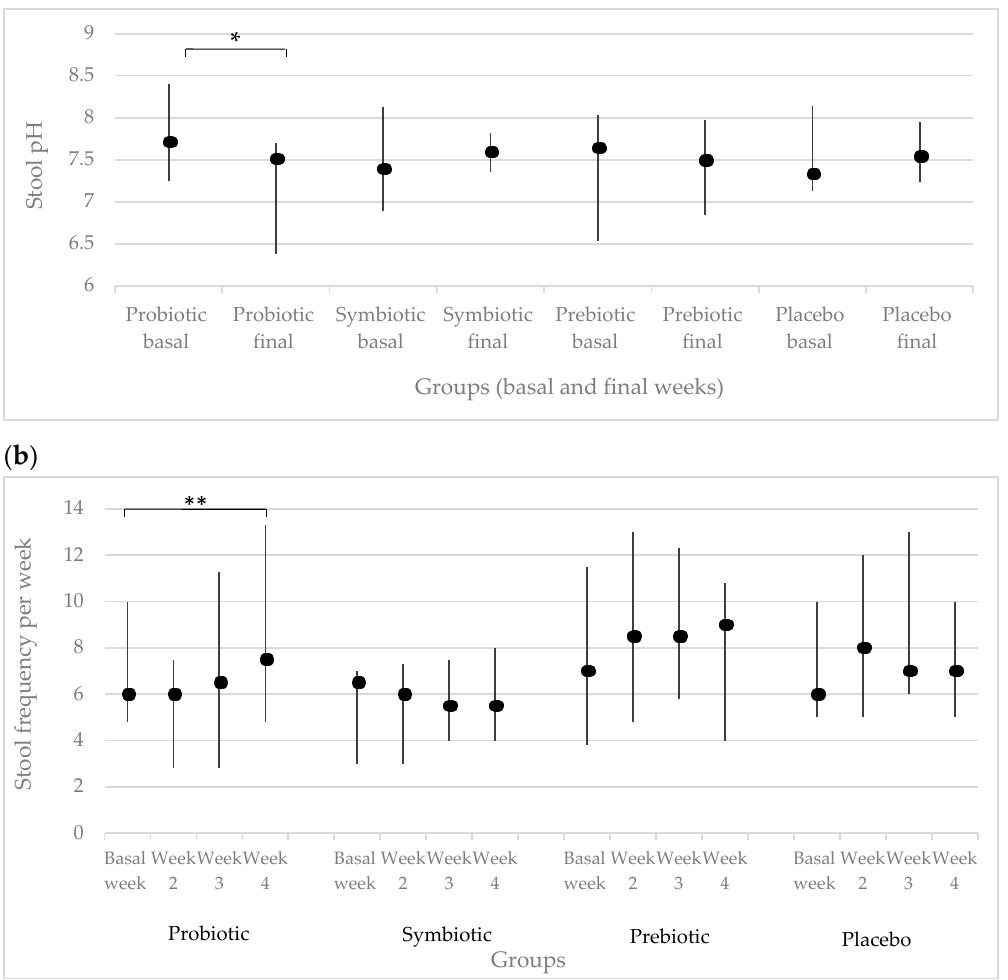
Figure 2. Stool characteristics (median and interquartile ranges). ( a ) Stool pH by group (basal vs final weeks), * p = 0.014; ( b ) Stool frequency per week by group, ** p = 0.034. Stool consistency was recorded as hard and normal stool. There was a tendency of decreased frequency of hard stool in all groups during the four weeks, except in the placebo group ( p > 0.05); however, only the prebiotic group showed significant improvement ( p = 0.008). The frequency of normal stool tended to increase except in the placebo group; only the prebiotic group showed significant improvement ( p = 0.003). The frequency of hard stool at the basal vs. final weeks of each group was compared to the placebo group. This difference was only significant when comparing the prebiotic to the placebo group ( p = 0.031) (Table 3).